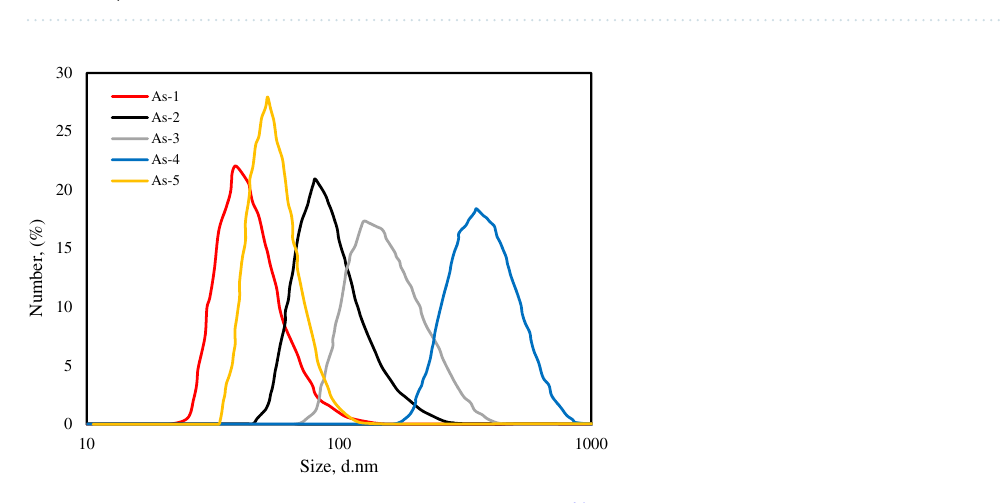
Figure 3. FTIR spectrum of asphaltene samples 26 and structural parameters of asphaltene samples based on FTIR analysis 17,26 .